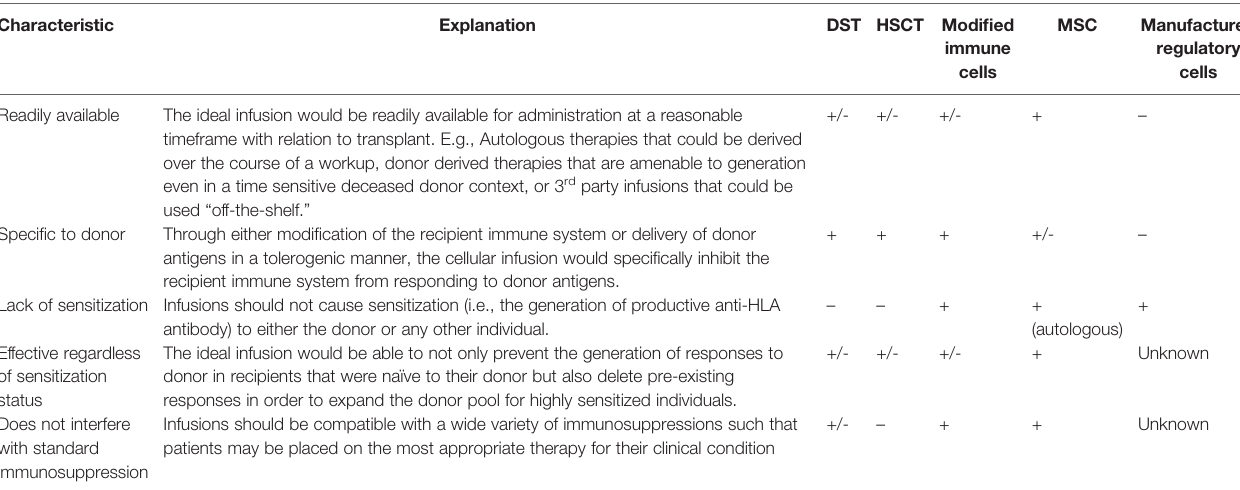
TABLE 1 | Ideal properties of a cellular infusion and whether current therapies meet those